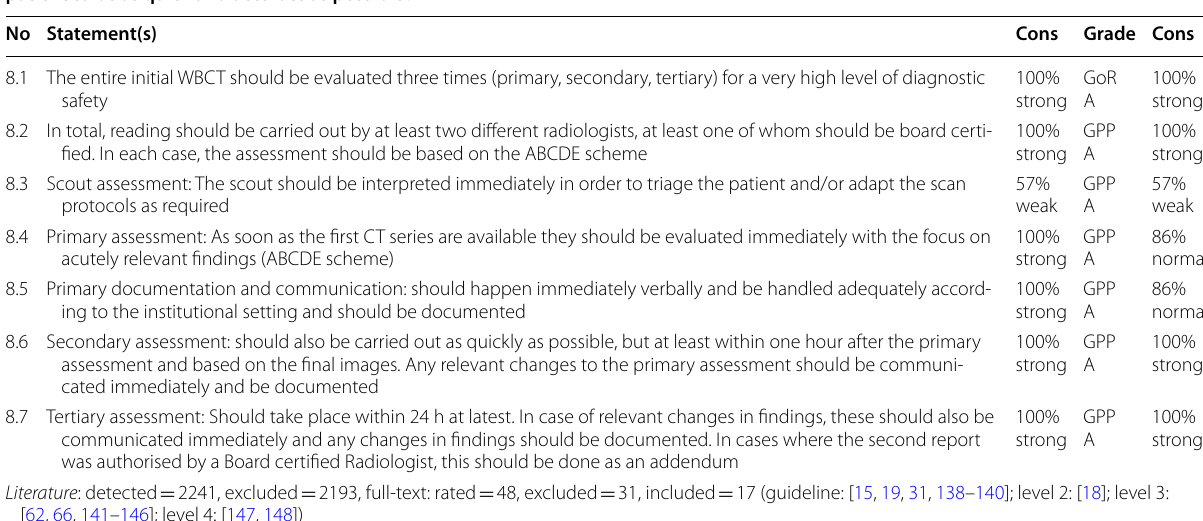
Table 17 Section 8: Whole Body CT – Reading/ Reporting Key question : What is the procedure for the assessment and evaluation of the whole body tomography scan in the case of a polytrauma patient to be as quick and accurate as